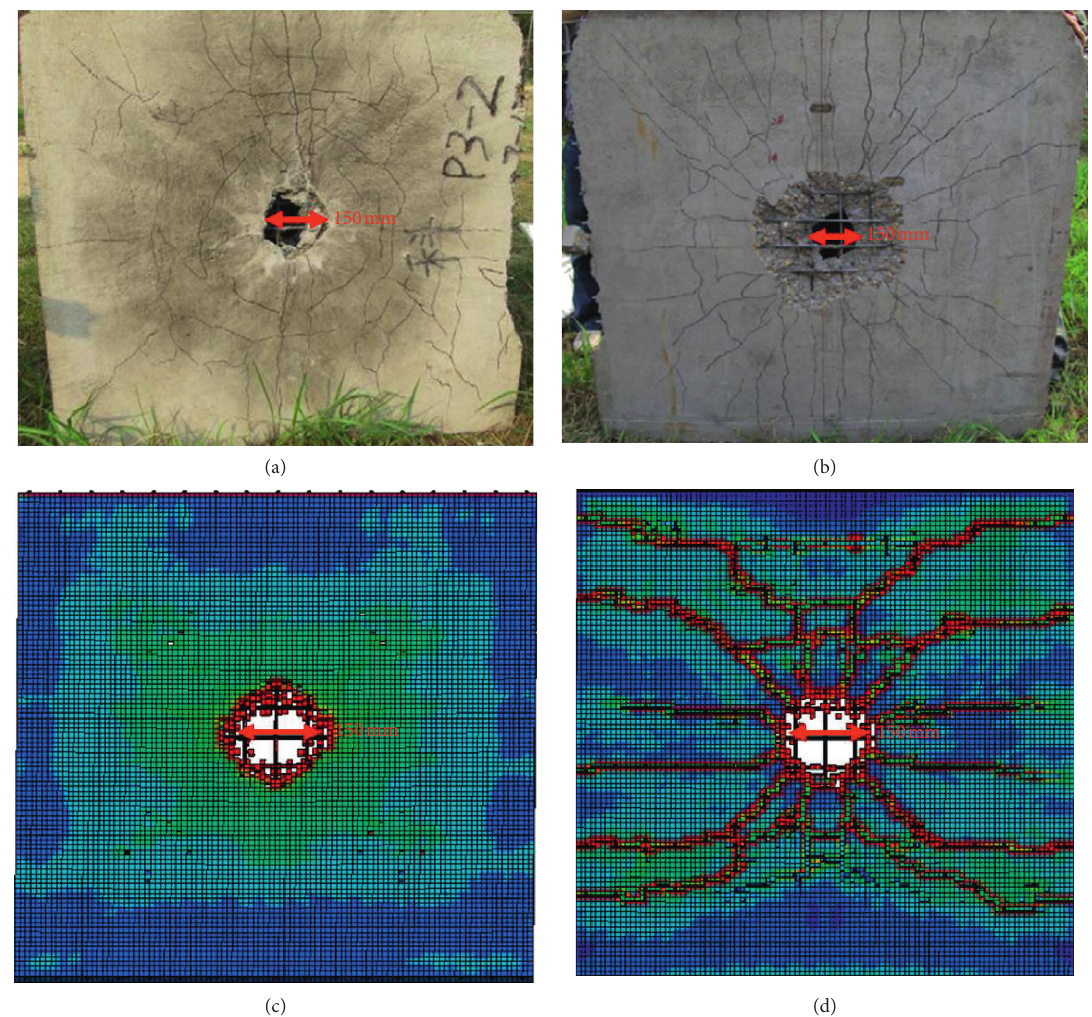
Figure 3: Comparison of experimental and numerical results: (a) front of the experimental model, (b) back of the experimental model, (c) front of the FE model, and (d) back of the FE model.